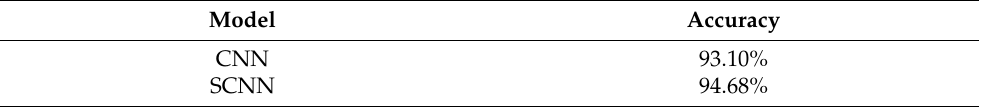
Table 5. The accuracy of the single model.